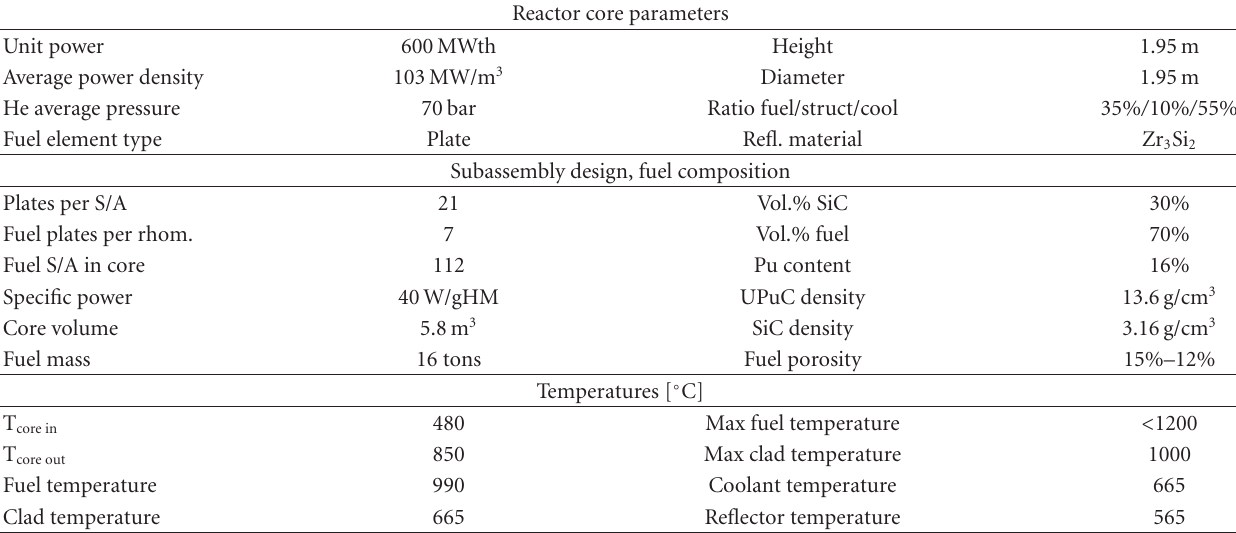
Table 2: Core parameters for GFR-600 design.